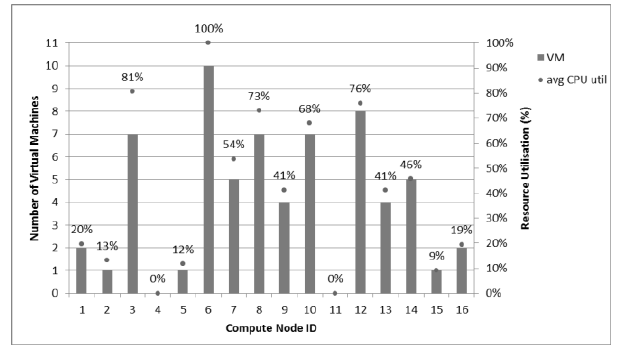
Figure 8. Aggregated CPU utilisation simulation